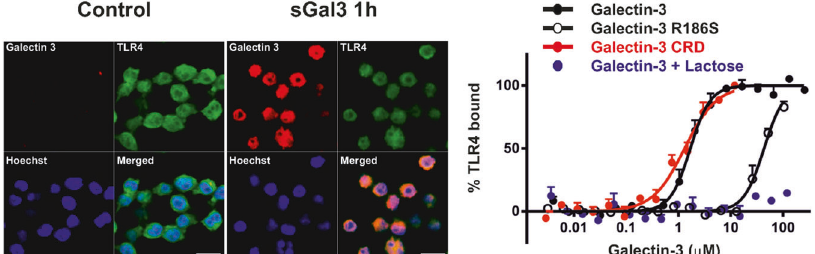
Fig. 1 Illustration from Burguillos et al. 2015 [31]: Gal-3 acts as a ligand to TLR4. Left panel: Colocalisation of Gal-3 and TLR4 in BV2 cells after 1 h exposure with sGal-3 protein. Right panel: Microscale thermophoresis was used to analyse the direct binding of TLR4 to Gal-3, Gal-3 CRD, Gal-3 R186S, and Gal-3 in the presence of inhibitory lactose (40 mM). Whereas the concentration of fl uorescently labelled TLR4 was kept constant, the non-labelled proteins were titrated ( x axis), and the minimal and maximal Fnorm values of the unbound and bound state of TLR4, respectively, were used to calculate the percent of TLR4 bound to Gal-3 ( y